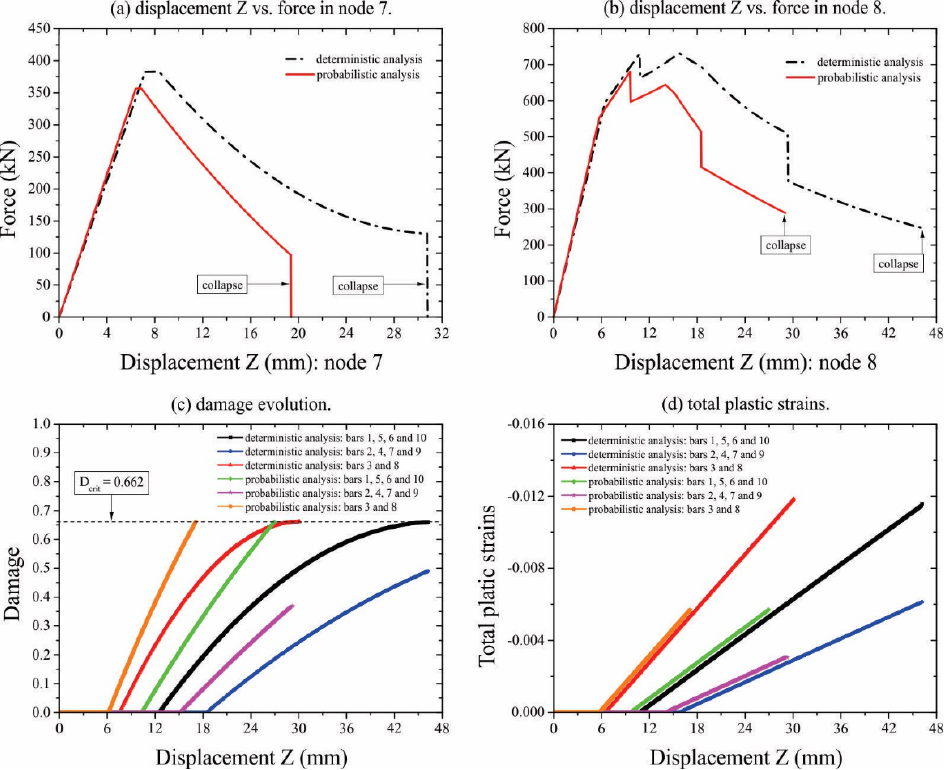
Figure 12. (a) Displacement Z vs. force in node 7; (b) displacement Z vs. force in node 8; (c) damage evolution and (d) total plastic strains in the bars: comparison between deterministic (mean value) and one sample of probabilistic